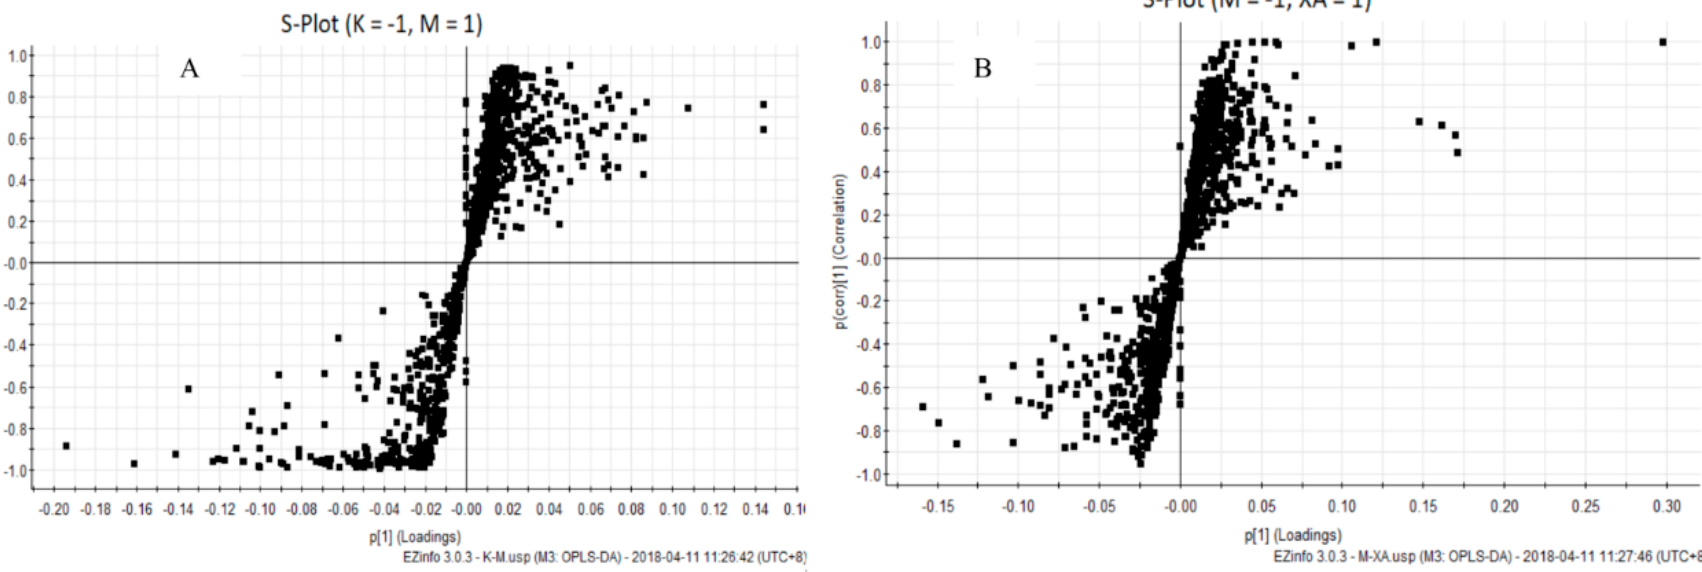
Figure 4. S-plot loadings plots of Control vs. Model group and Model vs. Administration group. ( A ): Control vs. Model group; ( B ): Model vs. Administration group.